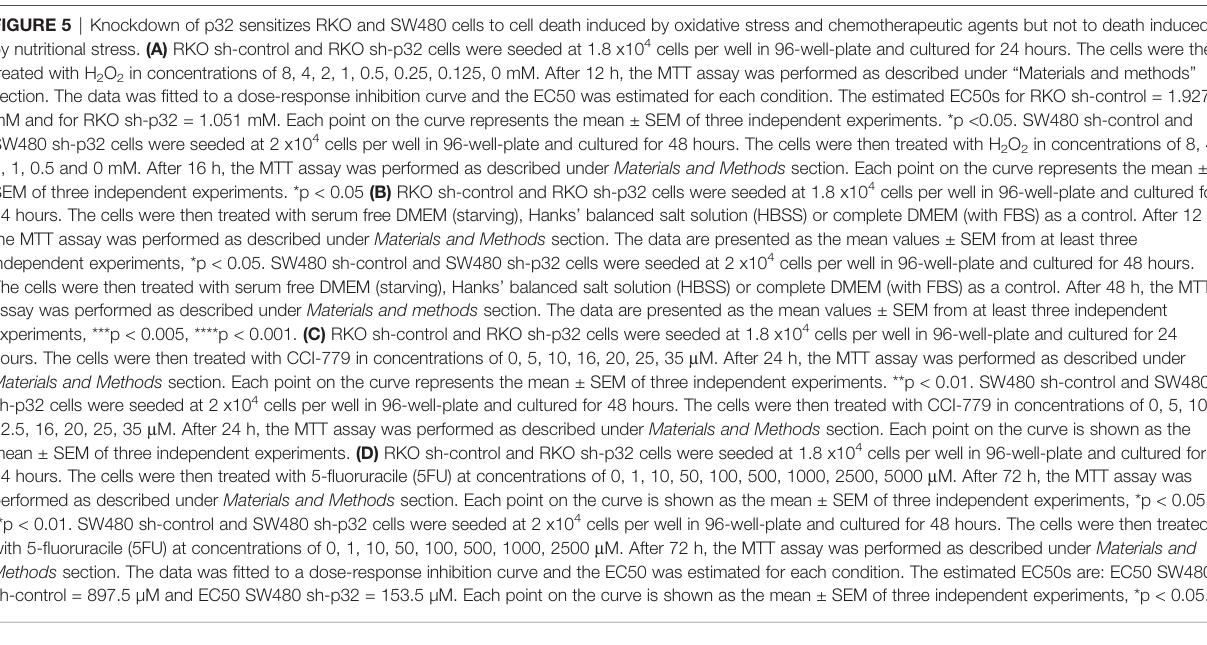
FIGURE 5 | Knockdown of p32 sensitizes RKO and SW480 cells to cell death induced by oxidative stress and chemotherapeutic agents but not to death induced by nutritional stress. (A) RKO sh-control and RKO sh-p32 cells were seeded at 1.8 x10 4 cells per well in 96-well-plate and cultured for 24 hours. The cells were then treated with H 2 O 2 in concentrations of 8, 4, 2, 1, 0.5, 0.25, 0.125, 0 mM. After 12 h, the MTT assay was performed as described under “ Materials and methods ” section. The data was fi tted to a dose-response inhibition curve and the EC50 was estimated for each condition. The estimated EC50s for RKO sh-control = 1.927 mM and for RKO sh-p32 = 1.051 mM. Each point on the curve represents the mean ± SEM of three independent experiments. *p <0.05. SW480 sh-control and SW480 sh-p32 cells were seeded at 2 x10 4 cells per well in 96-well-plate and cultured for 48 hours. The cells were then treated with H 2 O 2 in concentrations of 8, 4, 2, 1, 0.5 and 0 mM. After 16 h, the MTT assay was performed as described under Materials and Methods section. Each point on the curve represents the mean ± SEM of three independent experiments. *p < 0.05 (B) RKO sh-control and RKO sh-p32 cells were seeded at 1.8 x10 4 cells per well in 96-well-plate and cultured for 24 hours. The cells were then treated with serum free DMEM (starving), Hanks ’ balanced salt solution (HBSS) or complete DMEM (with FBS) as a control. After 12 h, the MTT assay was performed as described under Materials and Methods section. The data are presented as the mean values ± SEM from at least three independent experiments, *p < 0.05. SW480 sh-control and SW480 sh-p32 cells were seeded at 2 x10 4 cells per well in 96-well-plate and cultured for 48 hours. The cells were then treated with serum free DMEM (starving), Hanks ’ balanced salt solution (HBSS) or complete DMEM (with FBS) as a control. After 48 h, the MTT assay was performed as described under Materials and methods section. The data are presented as the mean values ± SEM from at least three independent experiments, ***p < 0.005, ****p < 0.001. (C) RKO sh-control and RKO sh-p32 cells were seeded at 1.8 x10 4 cells per well in 96-well-plate and cultured for 24 hours. The cells were then treated with CCI-779 in concentrations of 0, 5, 10, 16, 20, 25, 35 m M. After 24 h, the MTT assay was performed as described under Materials and Methods section. Each point on the curve represents the mean ± SEM of three independent experiments. **p < 0.01. SW480 sh-control and SW480 sh-p32 cells were seeded at 2 x10 4 cells per well in 96-well-plate and cultured for 48 hours. The cells were then treated with CCI-779 in concentrations of 0, 5, 10, 12.5, 16, 20, 25, 35 m M. After 24 h, the MTT assay was performed as described under Materials and Methods section. Each point on the curve is shown as the mean ± SEM of three independent experiments. (D) RKO sh-control and RKO sh-p32 cells were seeded at 1.8 x10 4 cells per well in 96-well-plate and cultured for 24 hours. The cells were then treated with 5- fl uoruracile (5FU) at concentrations of 0, 1, 10, 50, 100, 500, 1000, 2500, 5000 m M. After 72 h, the MTT assay was performed as described under Materials and Methods section. Each point on the curve is shown as the mean ± SEM of three independent experiments, *p < 0.05, **p < 0.01. SW480 sh-control and SW480 sh-p32 cells were seeded at 2 x10 4 cells per well in 96-well-plate and cultured for 48 hours. The cells were then treated with 5- fl uoruracile (5FU) at concentrations of 0, 1, 10, 50, 100, 500, 1000, 2500 m M. After 72 h, the MTT assay was performed as described under Materials and Methods section. The data was fi tted to a dose-response inhibition curve and the EC50 was estimated for each condition. The estimated EC50s are: EC50 SW480 sh-control = 897.5 µM and EC50 SW480 sh-p32 = 153.5 µM. Each point on the curve is shown as the mean ± SEM of three independent experiments, *p <